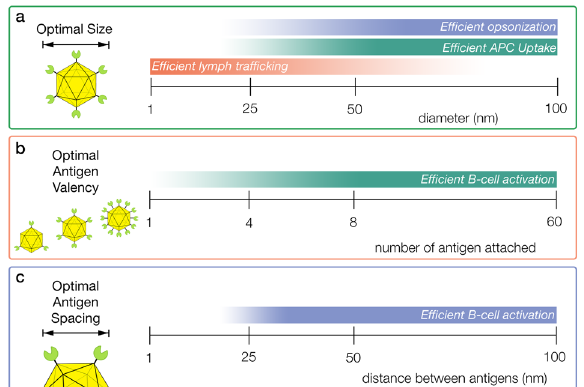
Fig. 5 Critical parameters of nanoparticle platforms and potential optimal ranges based on current research. Gradient increases in intensity from less optimal to most optimal. a Parameters for optimal size of a nanoparticle with a trend as size increases for enhanced opsonization and APC uptake, but inhibited lymph node traf fi cking. b Trend for improved B-cell activation as antigen valency increases. c The ideal range between antigen in order to facilitate ef fi cient B-cell activation, with potential steric constraints prevent- ing ef fi cient B-cell activation at distances below 28